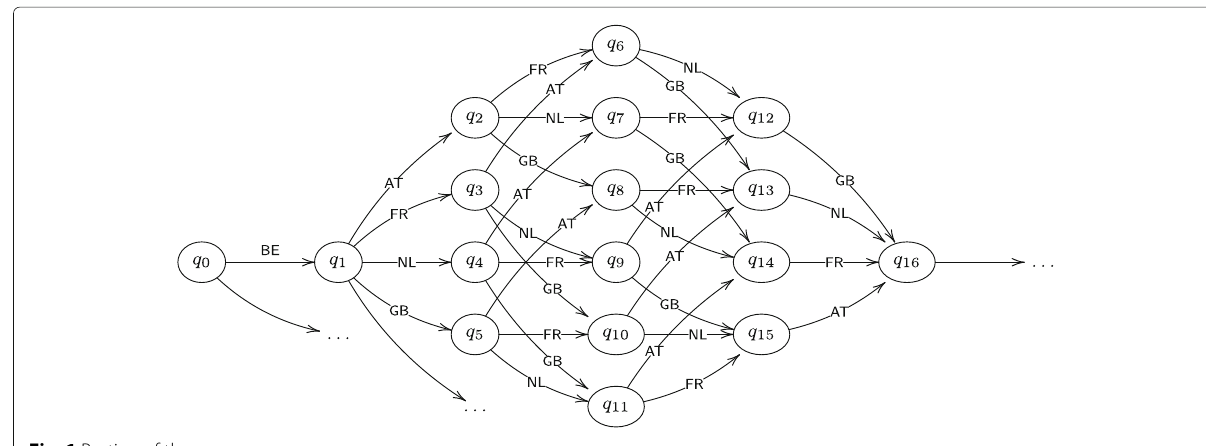
Fig. 1 Portion of the query